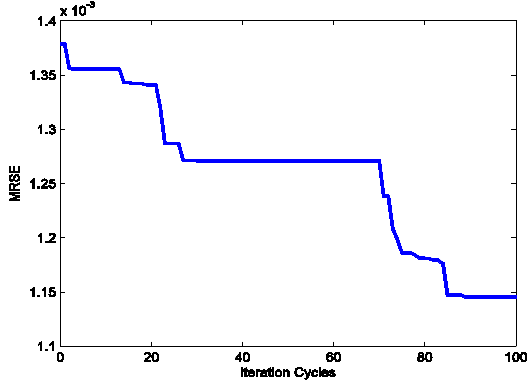
Fig. 4. Convergence history of MRSE